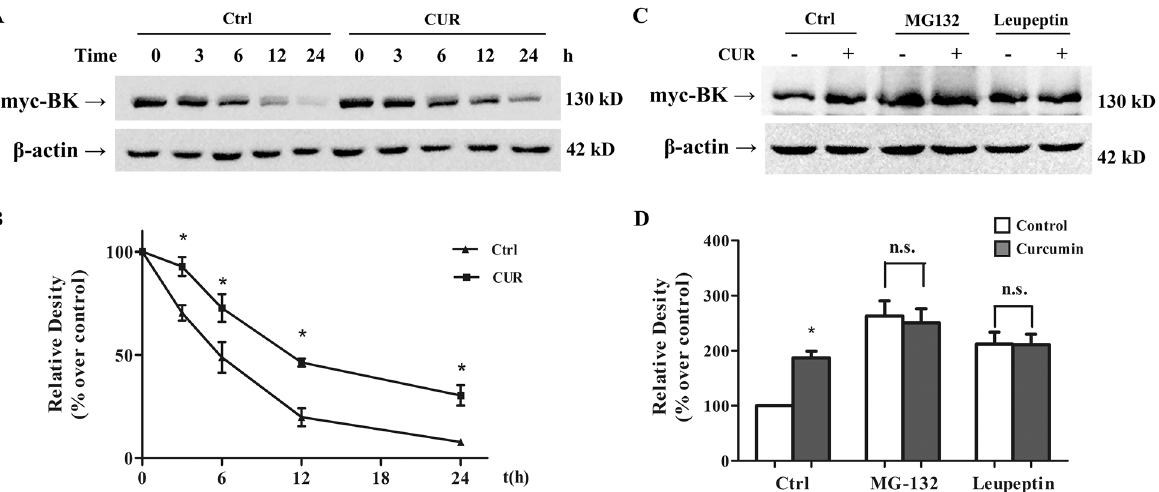
Fig 7. Curcumin increased BK protein stability via inhibition of degradation pathways. (A) Effect of curcumin on BK protein stability was examined with cycloheximide-chase assay. Western blot analysis showed that treatment with 10 μ M curcumin prolonged BK protein half-life. (B) Graphic representation of densitometric data showing the remaining BK protein level in Fig 7A (n = 3). (C) Effect of curcumin on BK protein in the presence and absence of proteasomal inhibitor, MG132. Western blot analysis showed that the increase of BK protein level was abolished by the proteasome inhibitor, MG132 (5 μ M). Inhibitors were applied 1 h before the administration of curcumin. (D) Graphic representation of densitometric data of the BK protein level in Fig 7C (n = 3). * p < 0.05; n. s., not significant.